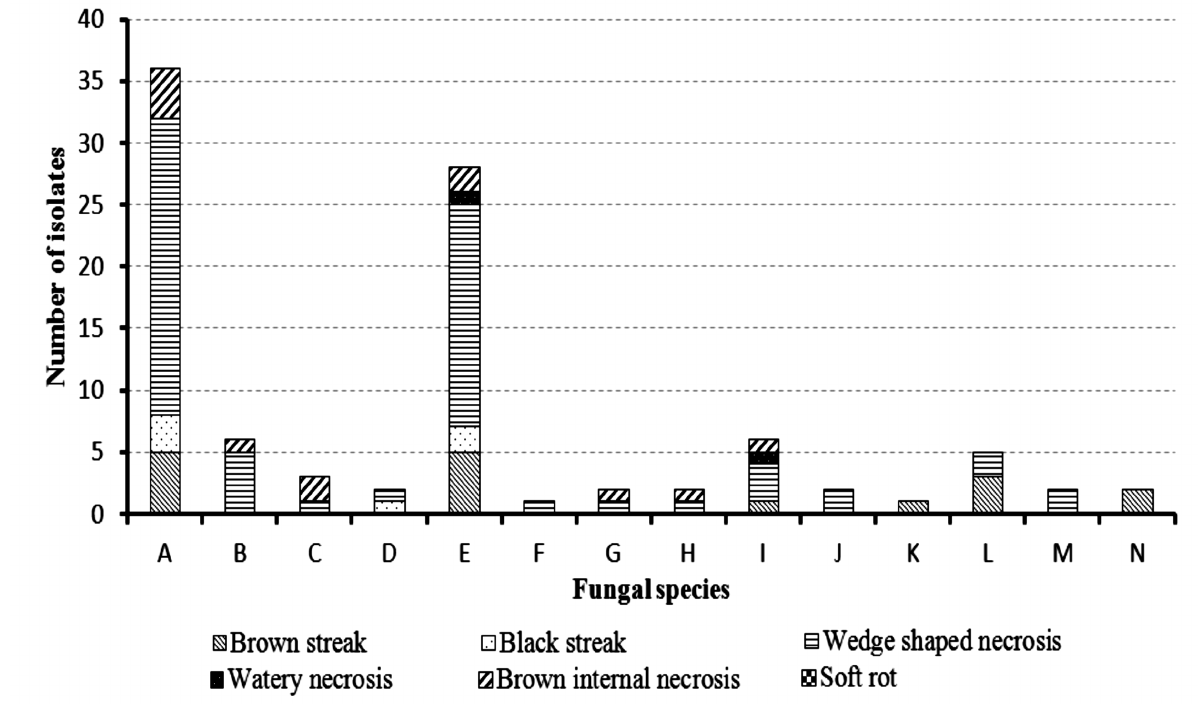
Figure 5. Frequency of isolation of fungal species from the six symptom types found on apple and pear trees with die- back symptoms. The fungi represented by the different bars include: A - Diplodia seriata , B - Diplodia pyricolum , C - Neofusicoccum australe , D - Neofusicoccum vitifusiforme , E - Phaeoacremonium aleophilum , F - Phaeoacremonium iranianum , G - Phaeoacremonium viticola , H - Phaeoacremonium mortoniae , I - Eutypa lata , J - Phomopsis sp. 7, K - Phomopsis theicola , L - Pyrenochaeta -like species, M - Paraconiothyrium braziliense and N - Paraconiothyrium variabile